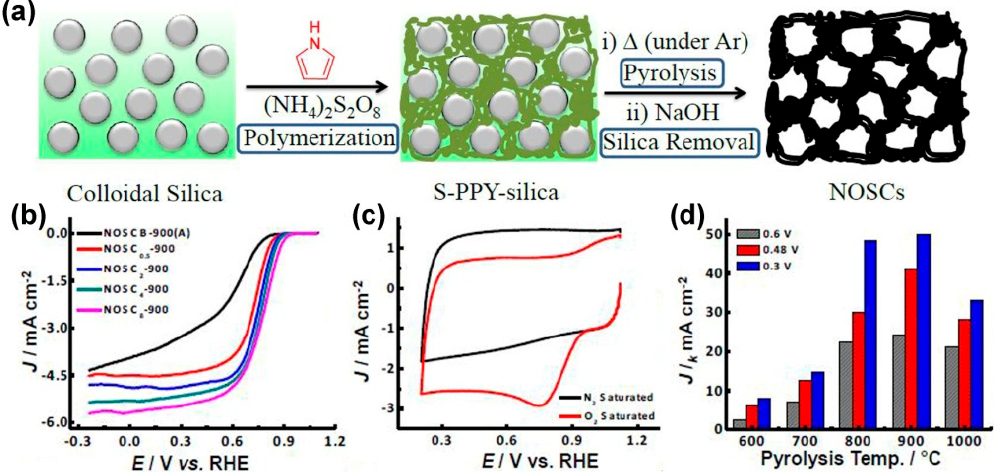
Figure 4. ( a ) Fabrication of N-, O-, and S-tridoped mesoporous carbon (NOSCs) with the ability of catalyzing ORR and AOR; ( b ) ORR polarization plots of NOSC x -900 materials on RDE rotating at 1600 rpm; ( c ) CV curves of NOSC 8 -900 in 0.1 M KOH conditions with O 2 and N 2 -saturated; and ( d ) kinetic current density ( J k ) of NOSC 8 -T catalysts for ORR at different potentials. Reprinted with permission from [58].